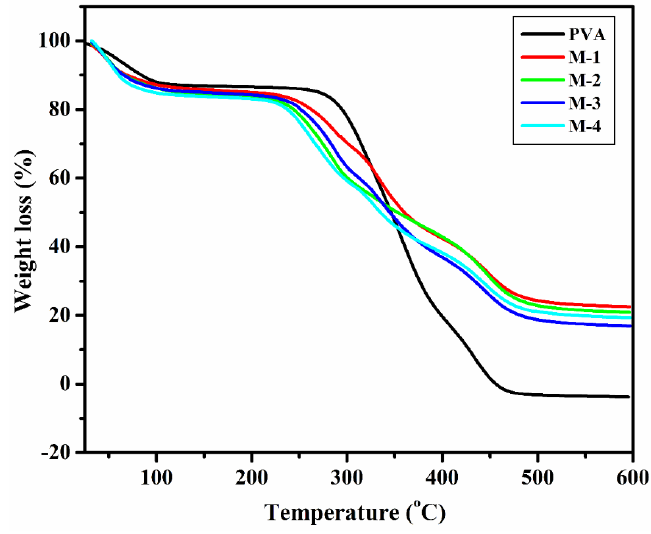
Figure 3. Thermogravimetric analysis patterns of PVA, CS-capped AgNP-incorporated PVA hybrid membranes: (M-1) 0.5 wt.%; (M-2) 1 wt.%; (M-3) 1.5 wt.%; (M-4) 2 wt.% of CS-capped AgNPs.